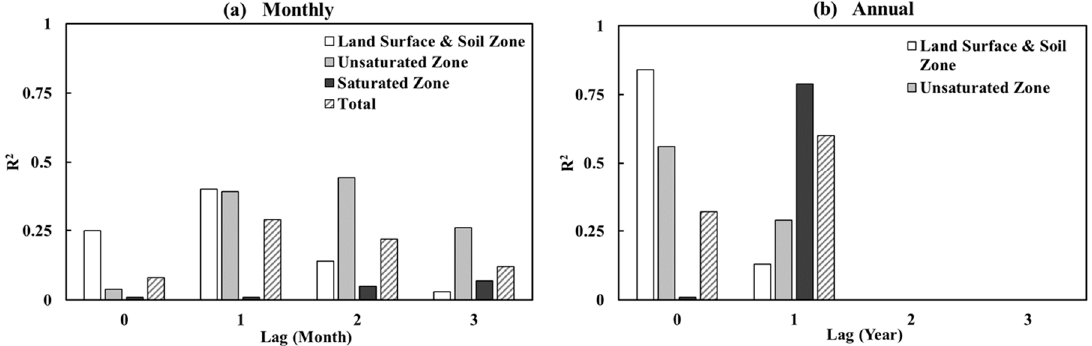
Figure 13. Lag correlations between the precipitation and storage changes in the surface and soil zone, unsaturated zone, saturated zone and whole system on ( a ) monthly and ( b ) annual time scales.